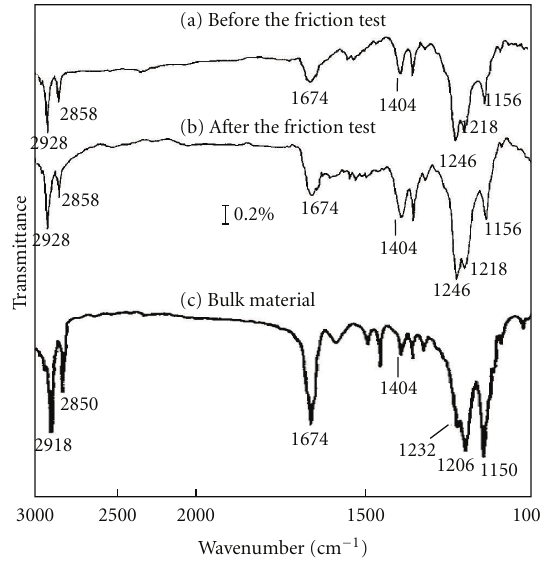
Figure 27: FTIR spectra of ammonium salt, C 7 F 15 -COO − H 3 N + - C 18 F 37 (Lubricant 5) (a) RAS spectra of adsorbed film (b) RAS spec- tra of adsorbed film after friction test (c) transmission spectrum of bulk